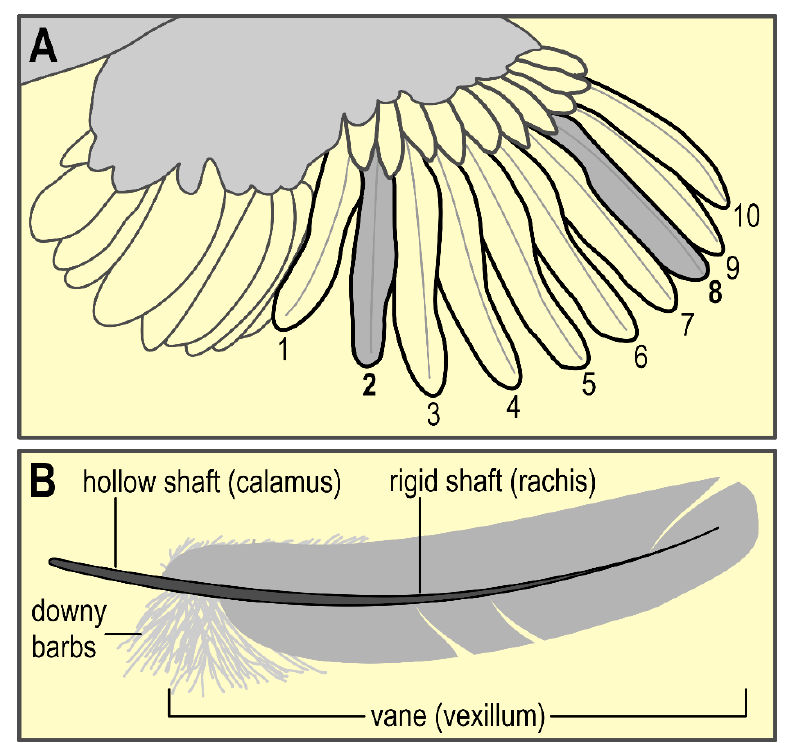
Figure 3. ( A ) Schematic representation of wing anatomy with numbering of primary feathers. For CORT analysis of the feathers, primary feather 2 and 8 were pulled in week 3 and 10. ( B ) Schematic representation of feather. Downy barbs, calamus, and rachis were removed prior to CORT analysis. Only the vanes were used for determination of corticosterone levels (illustration modified from [26]).